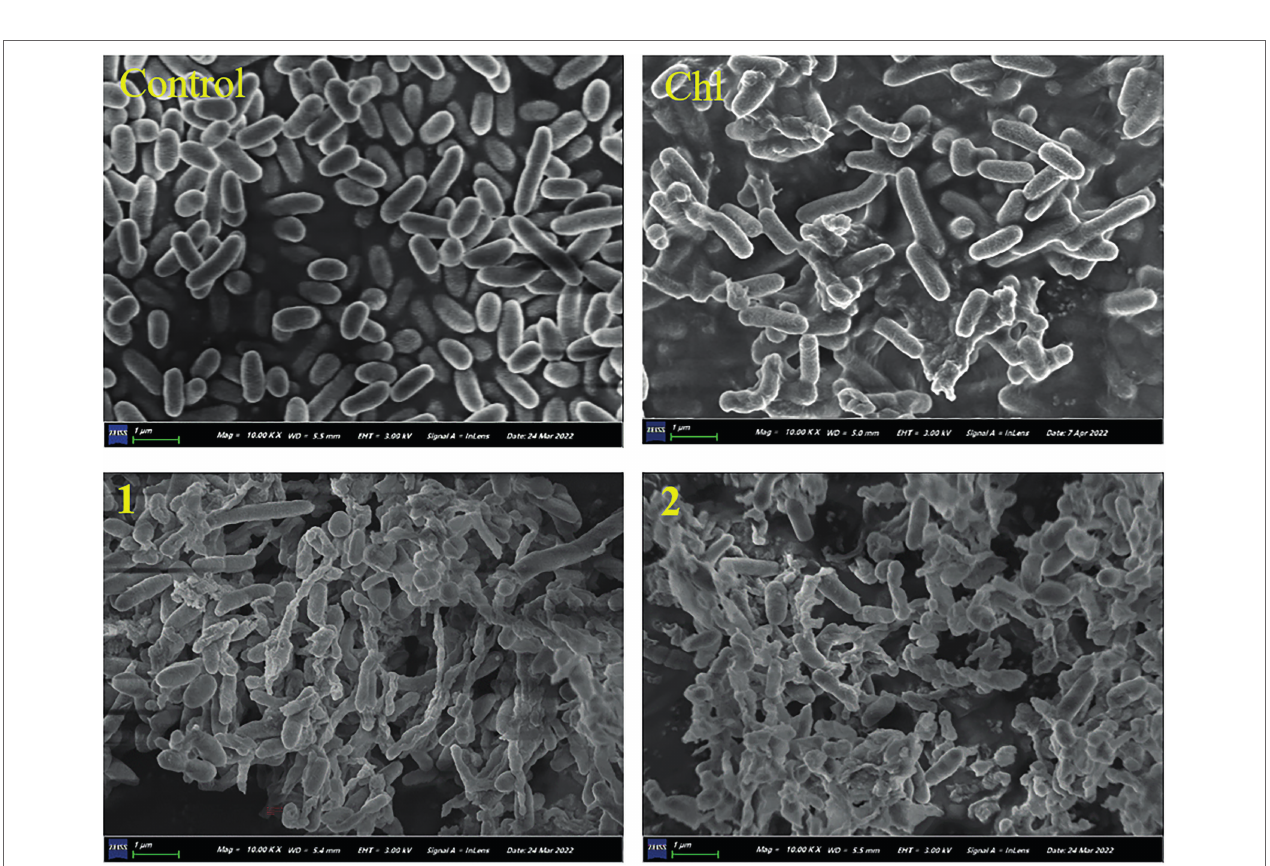
FIGURE 4 | Electron microscopic observation of morphological changes in Vibrio parahaemolyticus cells following treatment with 1 and 2 . (Chl,